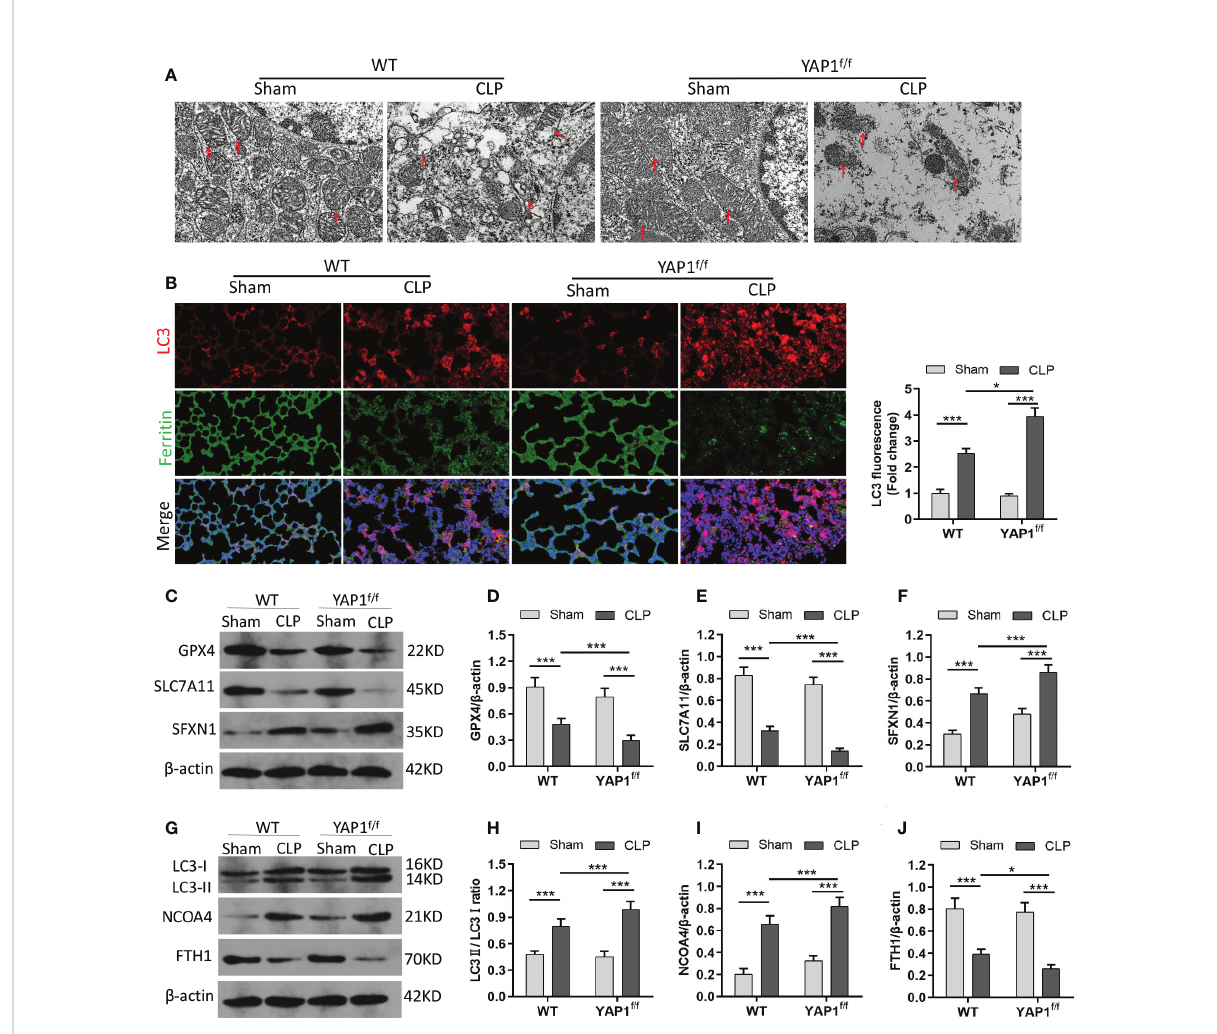
FIGURE 7 YAP1 de fi ciency aggravated CLP-induced ferroptosis and ferritinophagy in lung tissues. (A) Representative images shown by TEM. The red arrow indicates representative mitochondria in WT and YAP1 f/f mice lungs treated by CLP or not ( n = 3 mice/group). (B) Fluorescence analysis showed representative images of ferritin colocalization (green) with tissue expression of LC3 (red) and quanti fi cation fl uorescence intensity of LC3. Nuclei were counterstained by DAPI (blue). Light pink fl uorescence represented the colocalization of ferritin and LC3. (C – F) Immunoblotting detection of the expression contents of GPX4 (D) , SLC7A11 (E) , and SFXN1 (F) in mice with indicated treatment. (G – J) Immunoblotting determination of the expression levels of LC3II/LC3I (H) , NCOA4 (I) , and FTH1 (J) in mice with equivalent treatment. Data are expressed as mean ± SD. n = 6; * p < 0.05, ** p < 0.01, *** p <